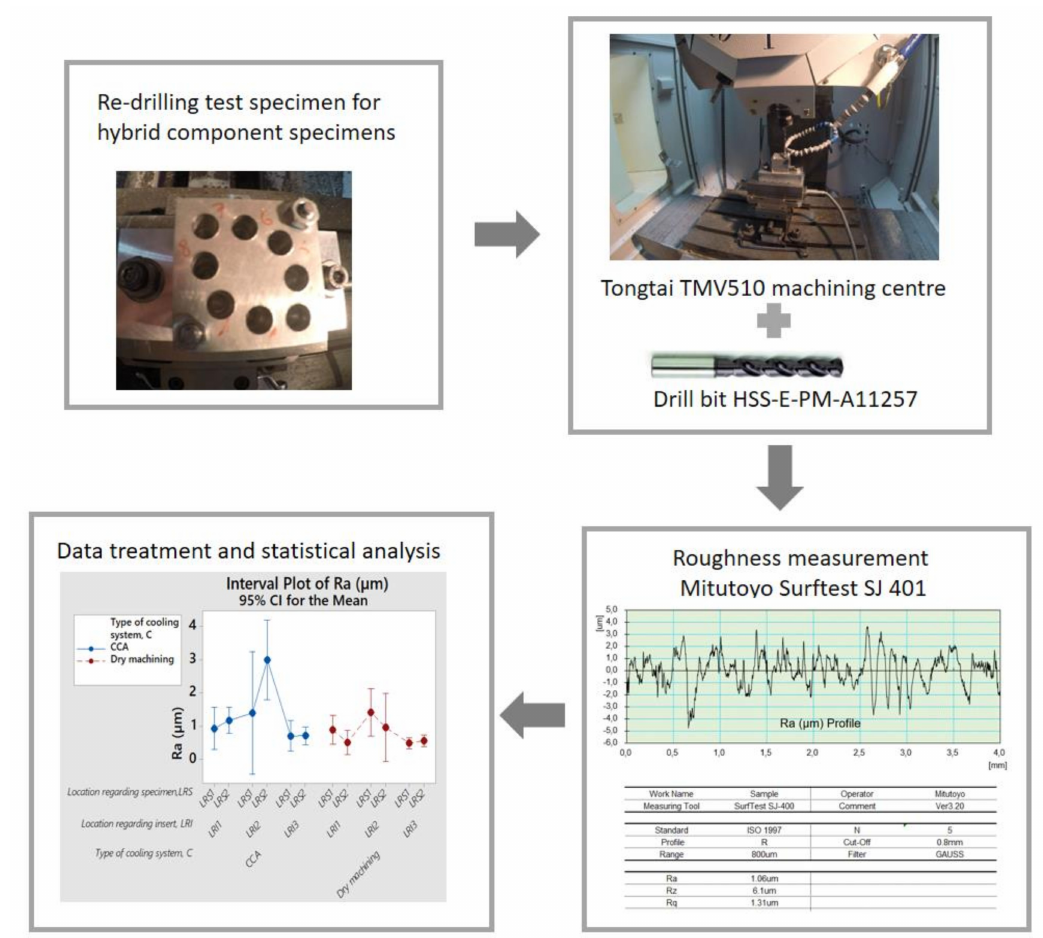
Figure 3. Schematic diagram of the experimental set-up for the re-drilling trials on Mg-Al-Mg multimaterial